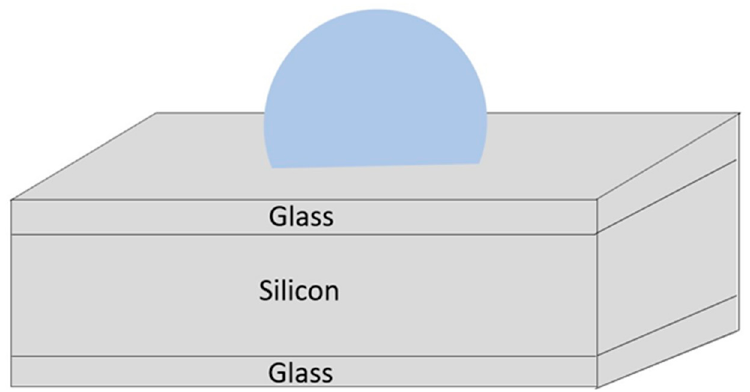
Figure 7. An individual spherical rubidium vapor cell with the external volume of 3 × 3 × 2 mm 3 .